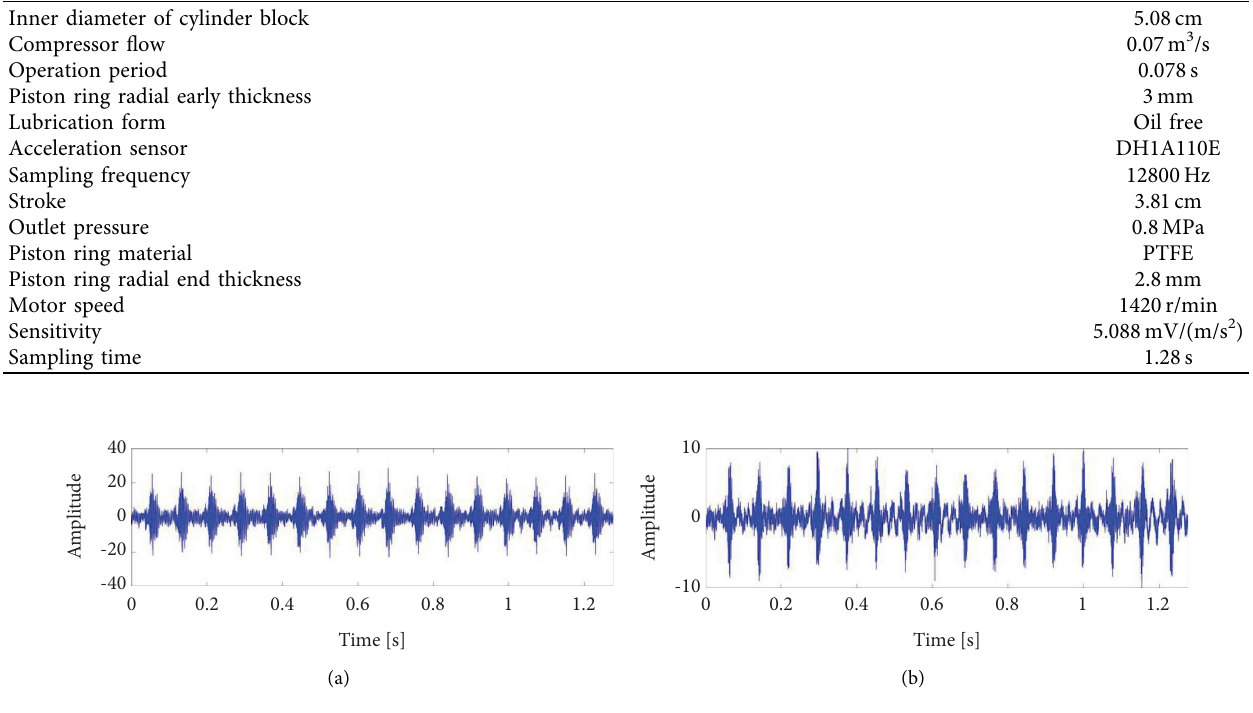
Figure 5: Time-frequency diagram of vibration signals. (a) Early stage. (b) Late